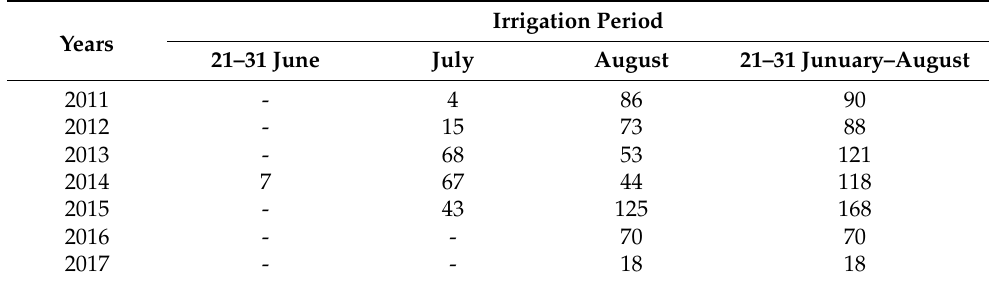
Table 4. Rainfall deficit (mm) in asparagus cultivation during the irrigation period in